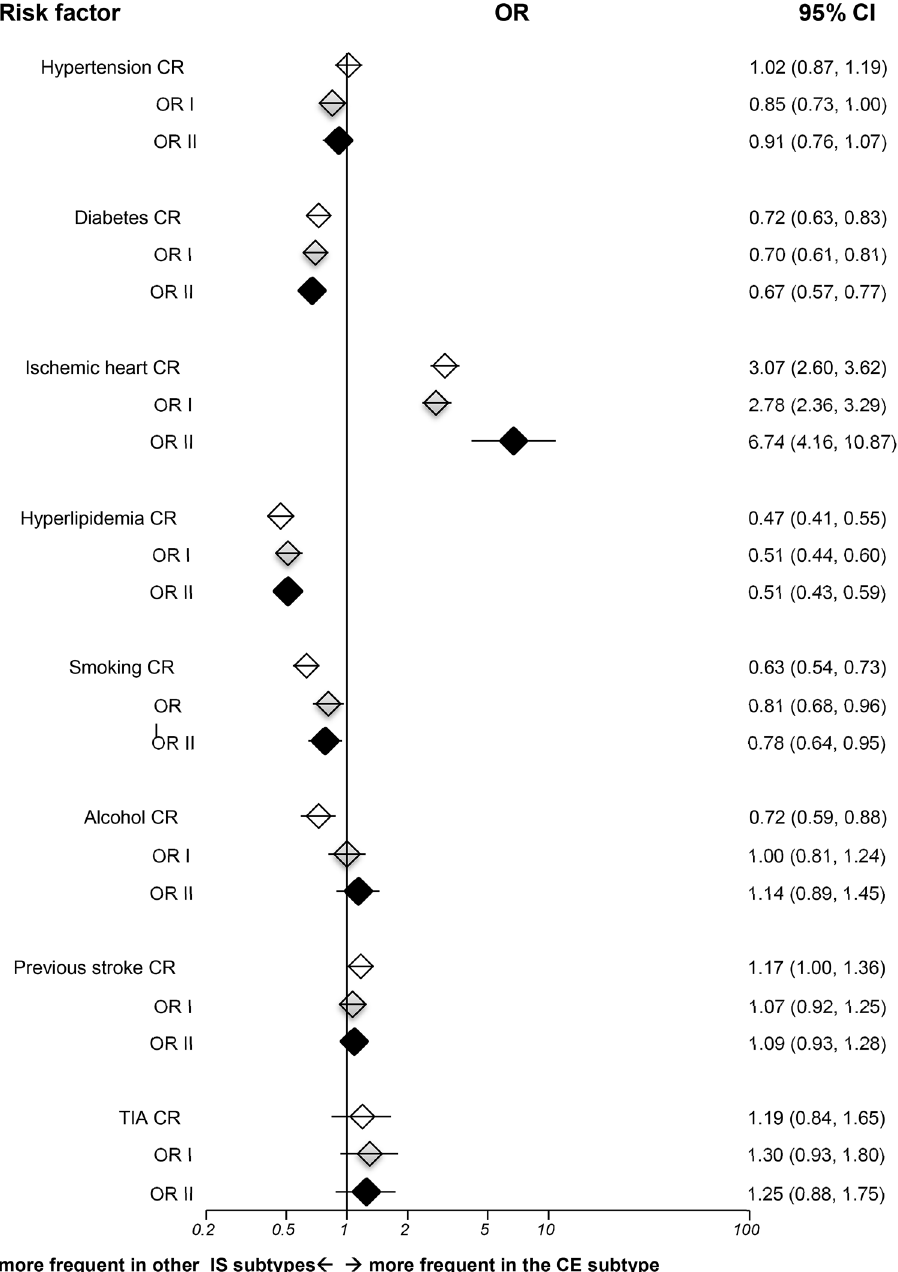
Figure 2. Risk factor analyses for cardioembolic strokes versus other ischemic subtypes in TOAST classification. IS = ischemic stroke; CE = cardioembolism; OR = odds ratio; CR = crude odds ratio; OR I = adjusted odds ratio I; OR II = adjusted odds ratio II; TIA = transient ischemic attack; CI = confidence interval; Horizontal lines represent 95% CIs. Diamonds represent pooled